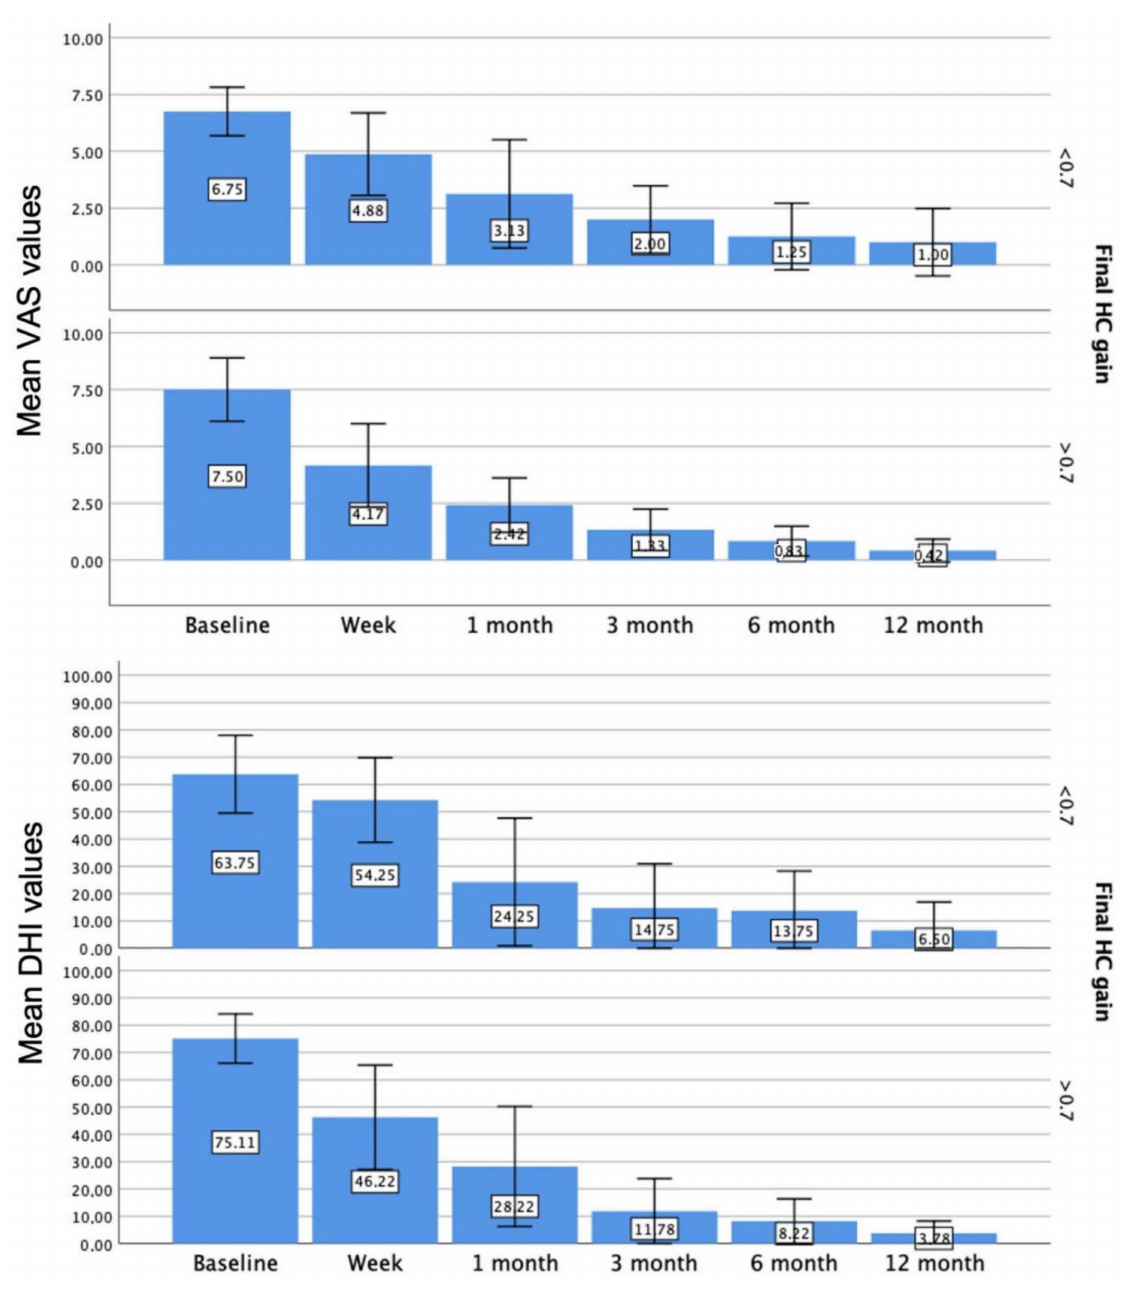
Figure 4. Bar chart for DHI and VAS score at every follow up, depending on the HC final